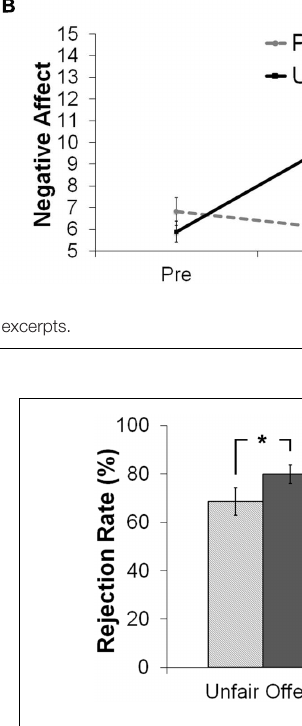
FIGURE 4 | Rejection rates across the two groups as a function of fairness. Error bars indicate the standard error of the mean. The asterisk indicates statistical significance ( p <